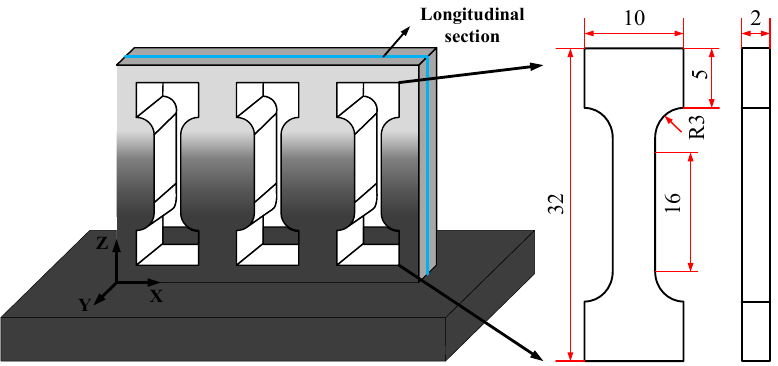
Figure 9. Position and geometry size (mm) of the tensile samples at the LMD thin-wall structure.